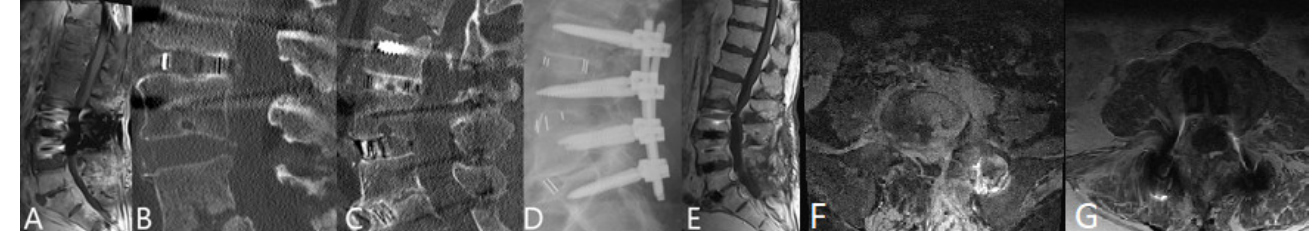
Figure 3. 66-year-old male patient with spondylodiscitis and epidural empyema due to an infection with pseudomonas aeruginosa at L4/5 and L5/S1 following the stabilization of L3/4 with an intervertebral cage due to degenerative spinal canal stenosis. ( A ). preoperative T1 post-contrast MRI of the lumbar spine shows spondylodiscitis at L4/5 and L5/S1 with intraspinal empyema. ( B ). preoperative CT of the lumbar spine shows infectious degeneration of L4/5 segment. ( C ). post- operative lumbar spine following extension of the fusion to S1 with cage implantation in L4/5 and L5/S1. ( D ). postoperative sagittal X ray of the lumbar spine shows the spinal construct. ( E ). postoperative MRI of the lumbar spine shows the com-